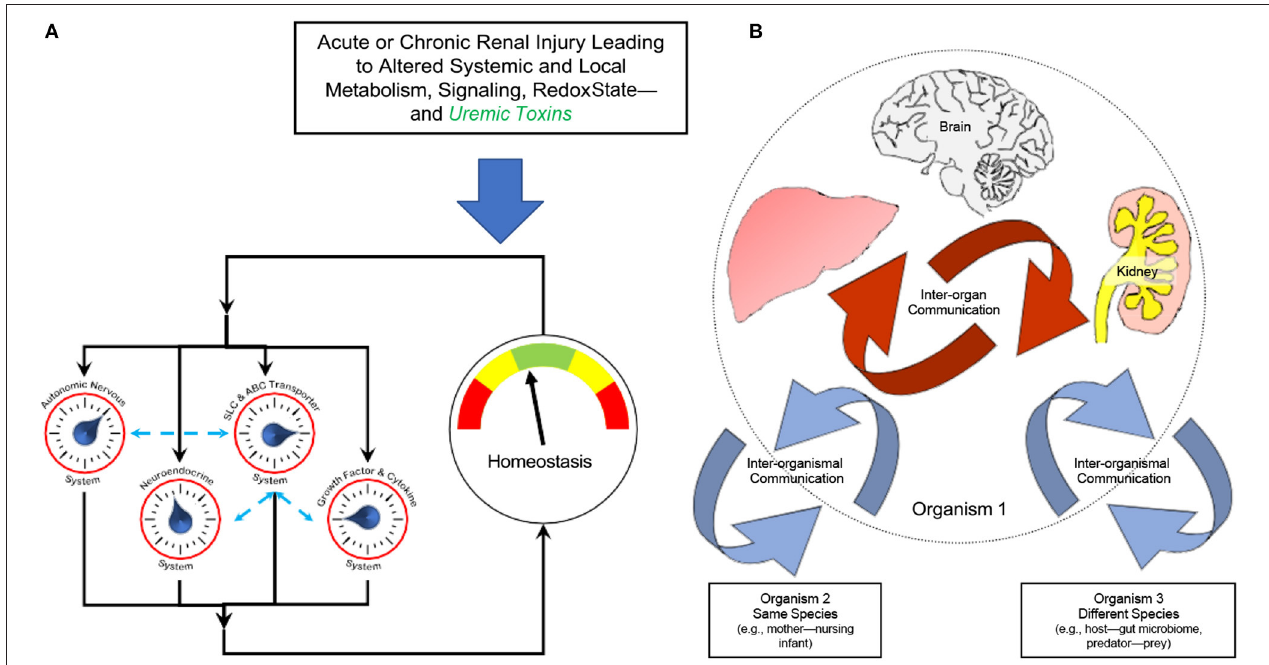
FIGURE 3 | Altered remote sensing and signaling in the context of kidney disease and uremic toxins. The Remote Sensing and Signaling Theory describes how proteins often considered to be primarily involved in the absorption, distribution, metabolism, and excretion (ADME) of small molecule drugs—including multispecific “drug” transporters like renal OAT1 and Phase 2 “drug” metabolizing enzymes like liver sulfotransferases—actually form a network mediating endogenous small molecule remote communication between organs and organisms. These small molecules have “high informational content” in that, like indoxyl sulfate, they are central to metabolism, signaling, and regulation of oxidative state. The expression of genes in the multiorgan (e.g., gut-liver-kidney) remote sensing and signaling network is regulated by, among other factors, nuclear receptors such as AHR, HNF4a, and FXR. A number of multi-specific transporters and enzymes work together with those of more limited (oligo- and mono-) specificity to potentially handle tens of thousands of endogenous and exogenous molecules in health and disease (e.g., CKD). (A) In acute or chronic organ injury, this complex adaptive system has the ability to reset until endogenous small molecule homeostasis is partially or completely restored. The Remote Sensing and Signaling System works in concert with other homeostatic systems (e.g., neuroendocrine system). (B) Inter-organismal communication can be between organisms of the same species (e.g., mother-nursing infant) or different species (e.g., gut microbes-host). Based on (1, 32, 34,